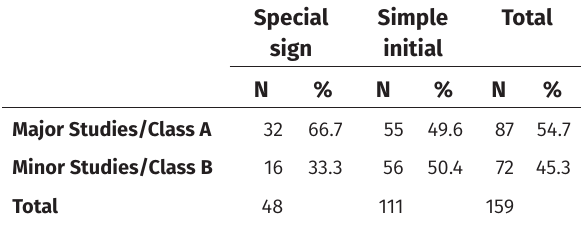
Table 5: Use of the special sign and simple initial depending on the level of education/socioeco- nomic stratum.